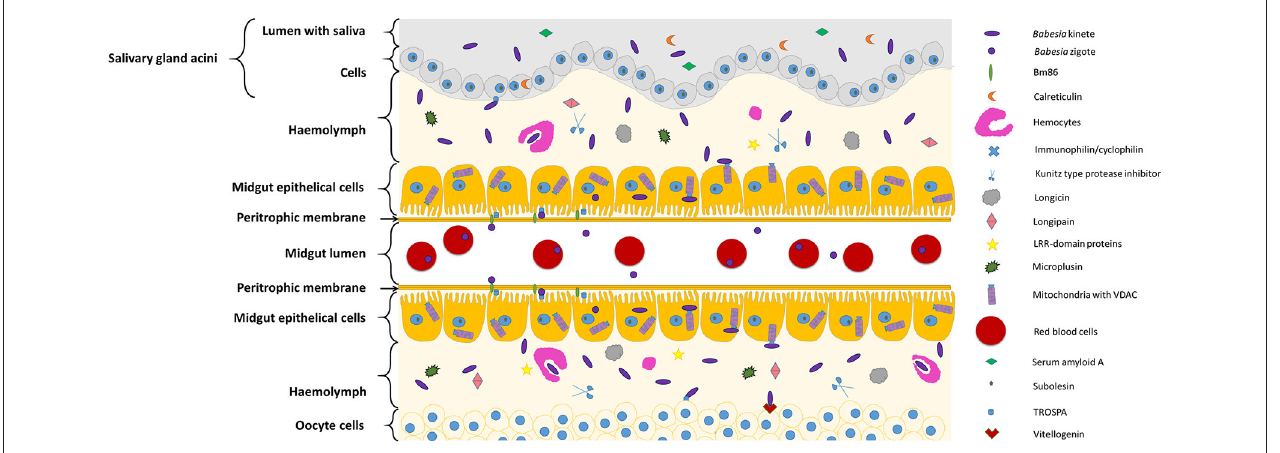
FIGURE 1 | Diagram representing tick molecules implicated in Babesia spp. acquisition and transmission by the vector. When ticks feed on Babesia -infected animals, parasites within red blood cellsreach and penetrate the tick midgut peritrophic membrane to invade the epithelial cells (in the figure center). Once these cells are infected, transcriptional factors, such as subolesin, can regulate protein expression in several cellular pathways, facilitating Babesia infection. In the microvilli of the midgut cells, parasite zygotes will probably interact with a tick glycoprotein (Bm86) and a tick receptor of the outer surface protein A (TROSPA). Inside the epithelial cells, mitochondria porins (VDAC) can bind to Babesia kinete proteins promoting plasminogen activation in the cell surface, allowing their passage to the haemolymph. Once here, the haemocytes can phagocyte circulating parasites and the tick antimicrobial molecules such as, longicin, micropulsin, longipain, LRR-domain and Kunitz-type protease inhibitors are activated potentially reducing the infection in the vector. If the infectious parasites surpass these barriers of defense, they will be capable to spread across the tissues and invade ovaries (represented in the bottom of the figure) and SGs (represented in the top of the figure). In the ovary, the interaction of Babesia molecules with tick vitellogenin and TROSPA receptors may contribute for the occurrence of transovarial transmission; while in the SGs, Babesia interacts with TROSPA and calreticulin.